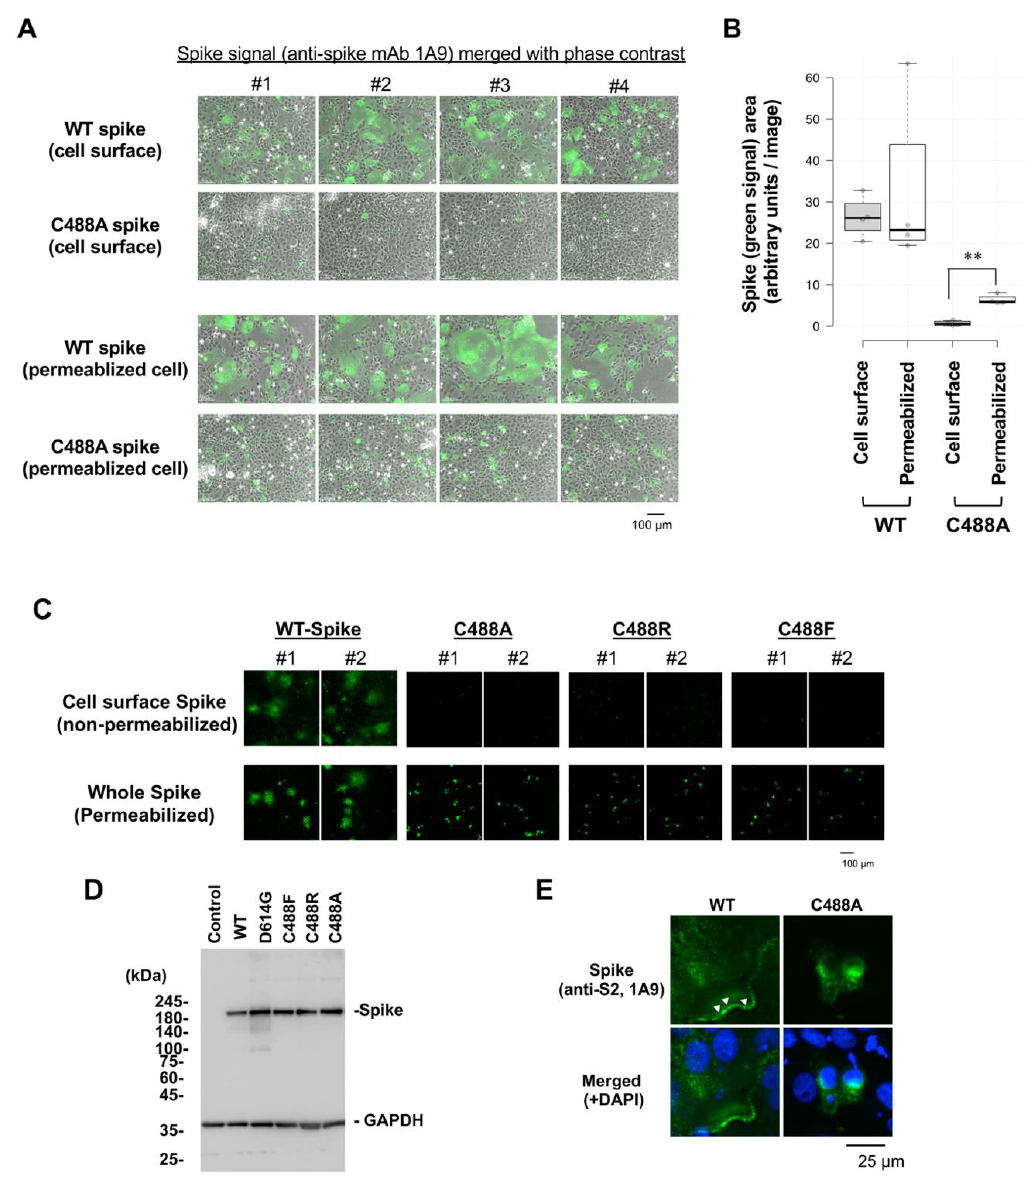
Figure 1. Loss of cell-surface expression of C488 mutant spike protein: ( A ) Wild-type (WT) and C488A mutant spike-expressing plasmids were transfected in Vero cells for 2 days. Cell surface spike protein was detected by anti-spike (1A9) antibodies and Alexa 488-conjugated secondary antibodies in non-permeabilized cells ( upper panels ). Intercellular spike protein was detected in Triton-X100 permeabilized cells ( lower panels ). ( B ) Green signals from spike-probed antibody in ( A ) were measured by ImageJ 1.44o. At least five images were analyzed in each setting. The spike-expressing area in C488A-expressing permeabilized cells was significantly larger than that in non-permeabilized cells. The Student’s t -test was performed to assess statistical significance. ** indicates p < 0.05. ( C ) Cell- surface expression of different C488 mutant spike proteins. WT and C488 mutant spike proteins were expressed in Vero cells for 2 days. Cell surface ( upper panels ) and whole intercellular ( lower panels ) spike proteins were detected, as in (A). The numbers #1 and #2 indicate two independent images. ( D ) Mutant spike protein expression was confirmed by Western blot analysis. GAPDH is shown as a loading control. ( E ) Subcellular localization of WT and C488A-mutant spike proteins in permeabilized Vero cells were analyzed by confocal microscopy. The green and blue signals represent spike proteins and DAPI-stained nuclei, respectively. The white arrowheads show spike proteins detected at plasma